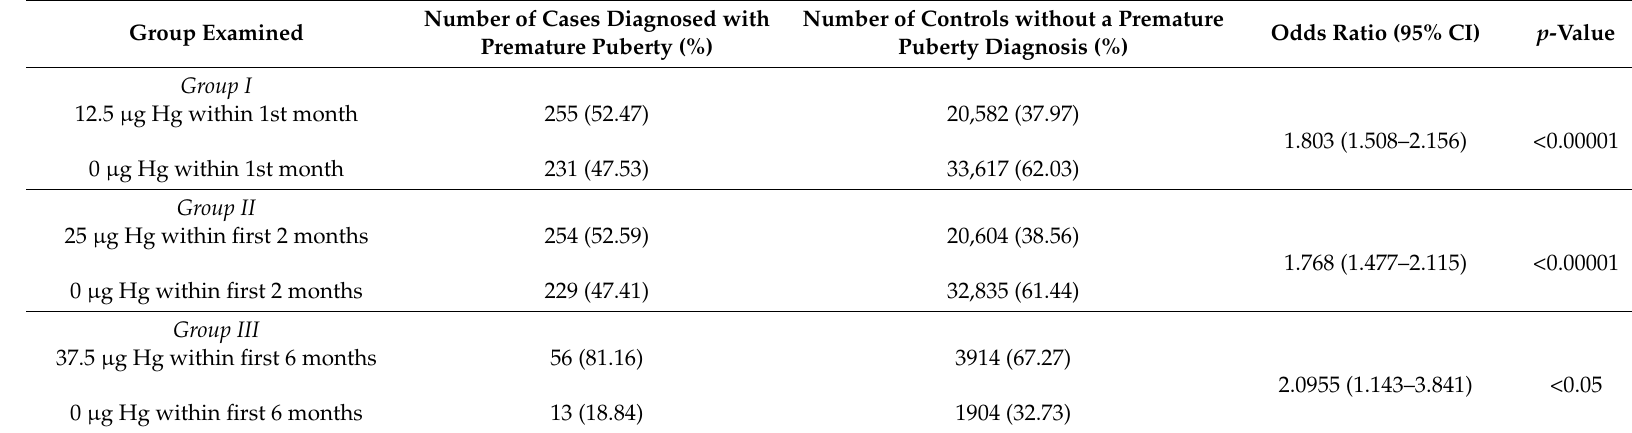
Table 1. This table summarizes the Hg exposure from Thimerosal-preserved HepB immunizations administered among cases with a premature puberty diagnosis compared to the control subjects 1 , within the database of the